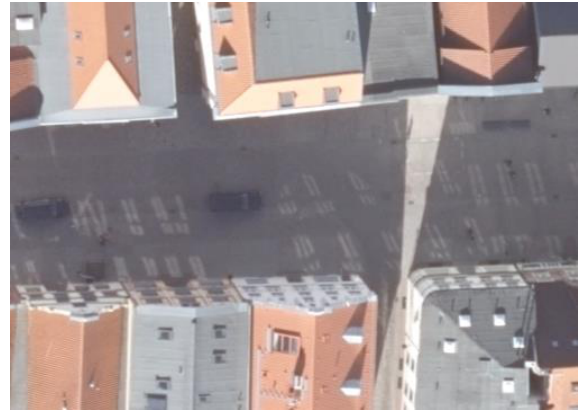
Figure 17. ATKIS-DOP with occluded areas in small alleys and backyards